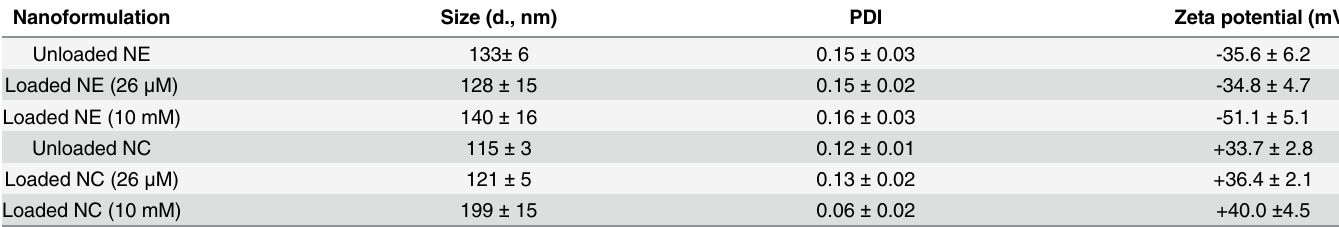
Table 2. Physicochemical properties of chitosan-coated nanocapsules and nanoemulsions with or without